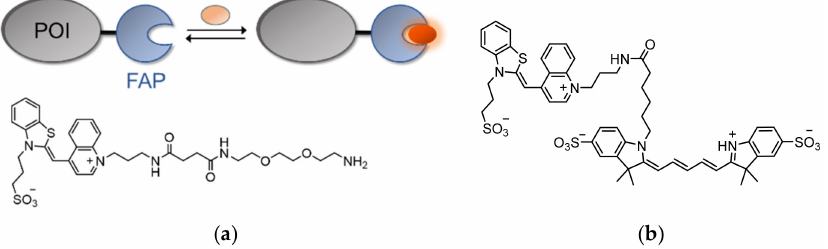
Figure 11. TO labeling of POIs fused to a fluorogen activating protein (FAP). ( a ) The operating principle of FAPs (top) and the structure of the TO-based fluorogen (bottom); ( b ) The structure of a pH-sensitive Cy5-linked TO fluoregen, which was used to track endocytosis of a membrane receptor fused to FAP. Internalization of the labeled target into acidic endosomes induced FRET between TO and the Cy5 analog